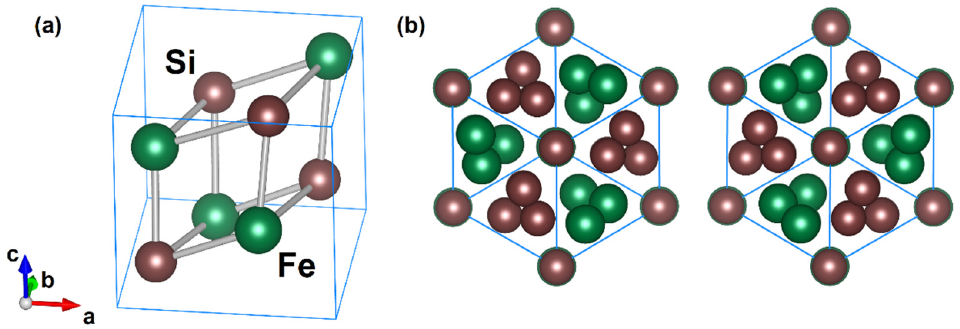
Figure 1. Crystal structure of the B20-type FeSi: the unit cell ( a ) and view of two enantiomers along the [111] axis ( b ).